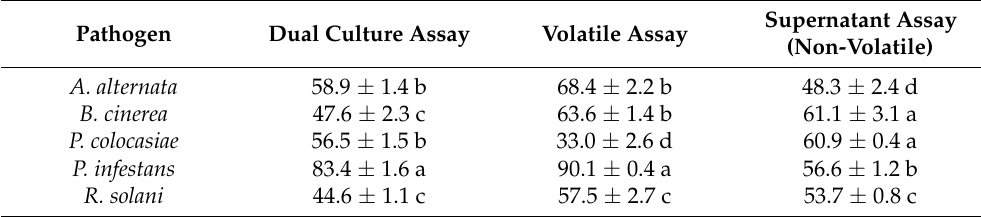
Table 1. Rates of phytopathogen inhibition by Pseudomonas aeruginosa strain FG106 in dual culture experiments and by its volatile and non-volatile metabolites.